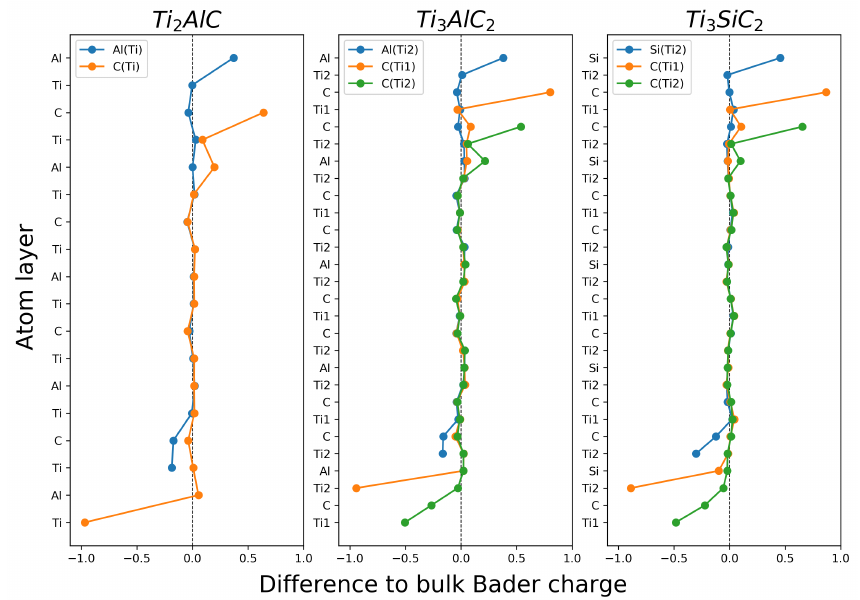
Figure 4. Bader charge difference for each surface of Ti 2 AlC, Ti 3 AlC 2 and Ti 3 SiC 2 compared to the corresponding bulk Bader charge. The Bader charge differences are aligned to their atomic